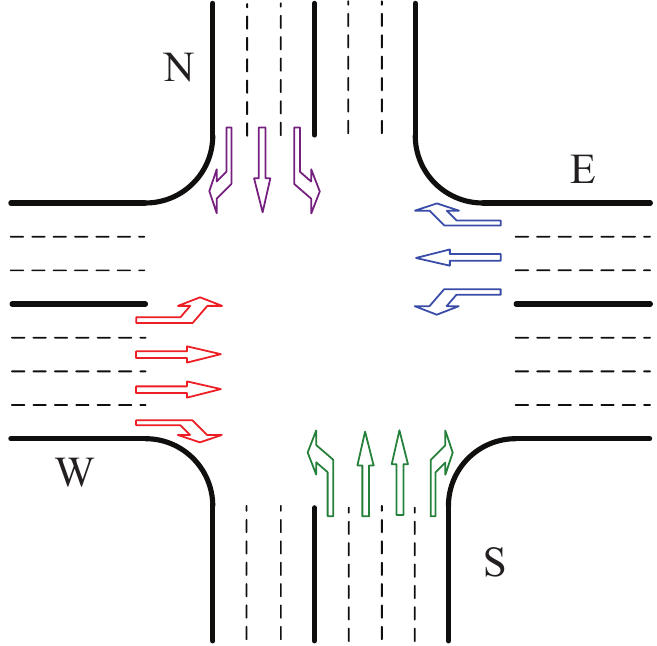
Figure 2. Layout of the considered